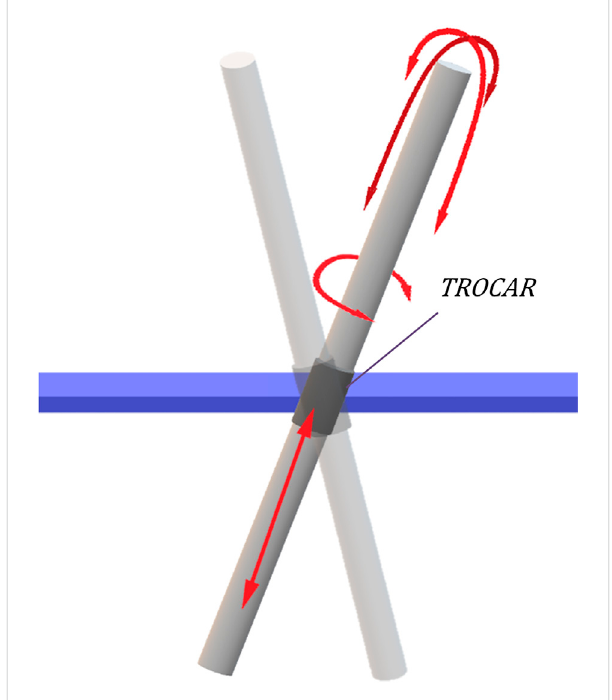
FIGURE 1 FourDoFsavailableusingtheRCMapproach,whichiscoincident with the trocar